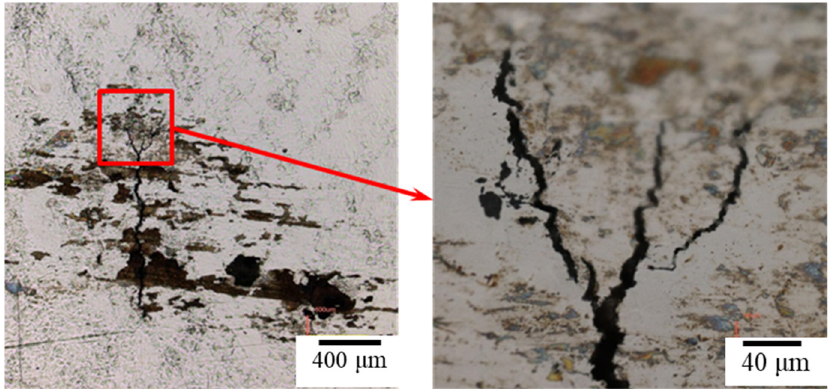
Figure 8. The crevice corrosion specimen with 0.1 g/m 2 of sea salt deposited on the surface subjected to tensile stresses of 400 MPa reveals cracks after 1500 h of testing at 45 °C and a relative humidity of 45%.